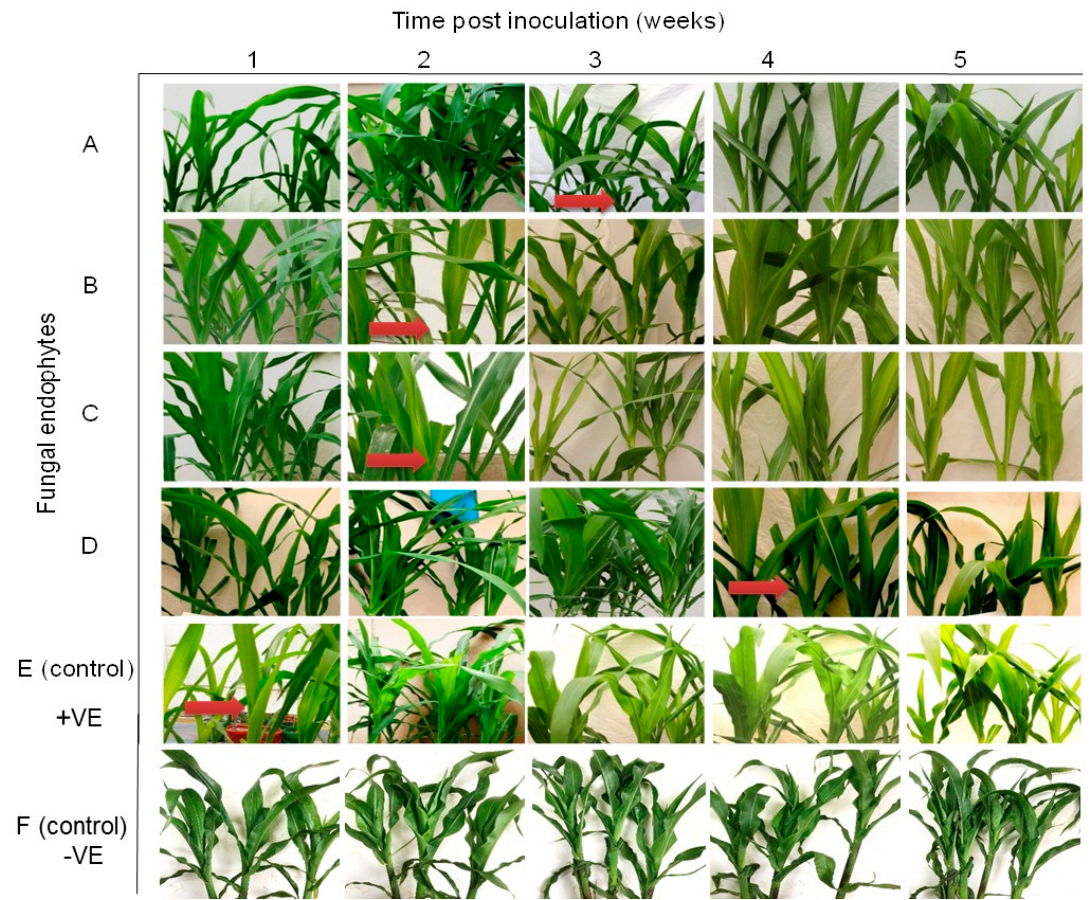
Figure 3. Disease symptom development in maize plants inoculated with fungal isolates, ( A ) ( Metarhizium anisopliae -ICIPE 69), ( B ) ( Trichoderma atroviride -F5S21), ( C ) ( Hypocrea lixii -F3ST1) and ( D ) ( Trichoderma harzianum -F2L4) following artificial inoculation with Sugarcane mosaic virus (SCMV). Panel ( E ) represents the positive control, where untreated maize plants were challenge-inoculated with SCMV, while ( F ) represents the negative control, where plants were neither treated with fungal endophytes nor challenge-inoculated with SCMV. The arrows indicate the onset of symptom expression in various treatments. Challenge inoculation with Sugarcane mosaic virus was conducted 21 days after planting.